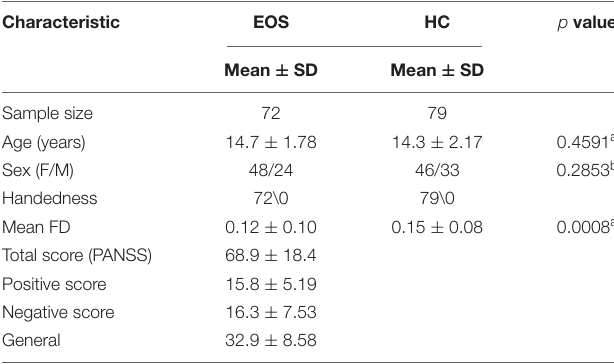
FD, frame-wise displacement; PANSS, Positive and Negative Syndrome Scale; Mean ± SD, values are mean ± standard deviation; F/M, Female/Male. a Mann- Whitney U-test. b Chi-square